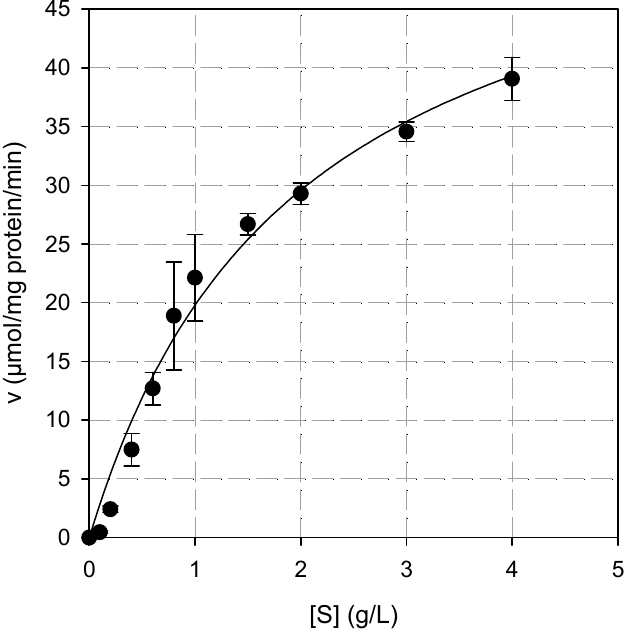
Figure 3. The Michaelis–Menten plot for the determination of the kinetic constants of oat spelt hydrolysis by BsXyn10.